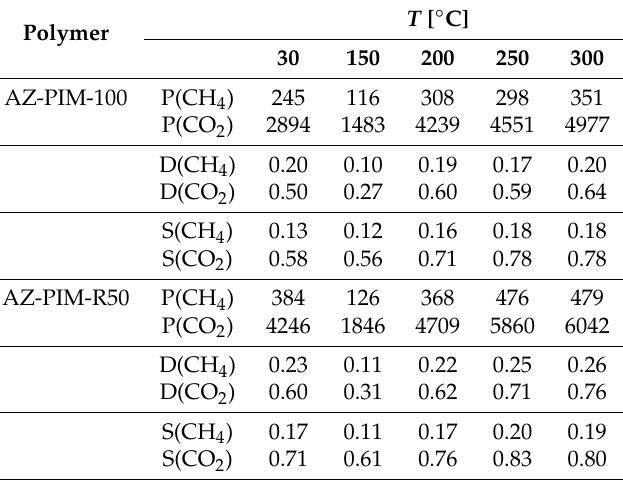
Table2. PermeabilityP (Barrer), di ff usivityD ( × 10 − 6 cm 2 / s)and solubilityS (cm 3 / cm 3 cmHg)coe ffi cients of CH 4 and CO 2 after thermal treatment of azide modified Table 2. Permeability P (Barrer), diffusivity D (×10 − 6 cm²/s) and solubility S (cm³/cm³ cmHg) coefficients of CH 4 and CO 2 after thermal treatment of azide modified PIMs.